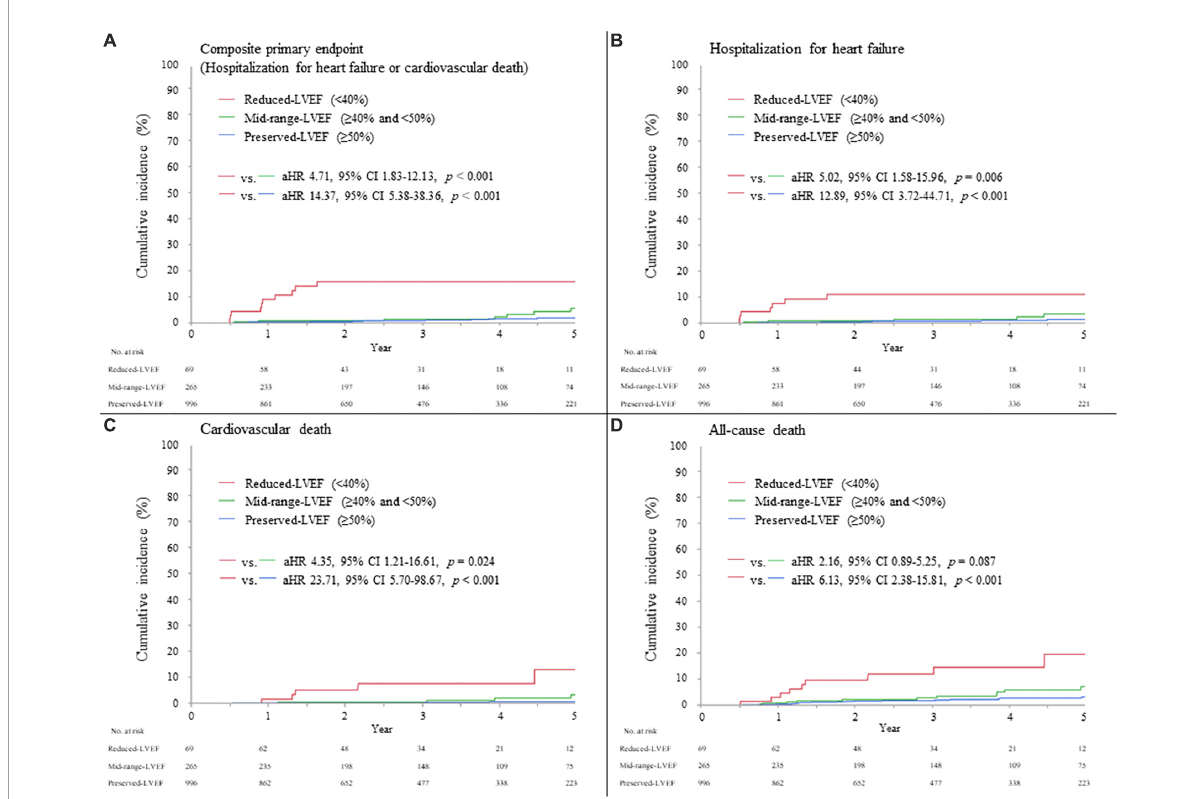
FIGURE3 Clinical events during follow-up, according to LVEF category 6 months after AMI. (A) Composite primary endpoint (hospitalization for heart failure or cardiovascular death). (B) Hospitalization for heart failure. (C) Cardiovascular death. (D) All-cause death. The hazard ratio was adjusted by age, sex, STEMI, maximum creatine phosphokinase (natural log-transformed), LVEF during index hospitalization, eGFR, use of mechanical support, and use of each medication (ACE-I, ARB, and β -blockers) at discharge. ACE-I, angiotensin-converting enzyme inhibitor; AMI, acute myocardial infarction; aHR, adjusted hazard ratio; ARB, angiotensin II receptor blocker; CI, confidence interval; LVEF, left ventricular ejection fraction; STEMI, ST-segment elevation myocardial